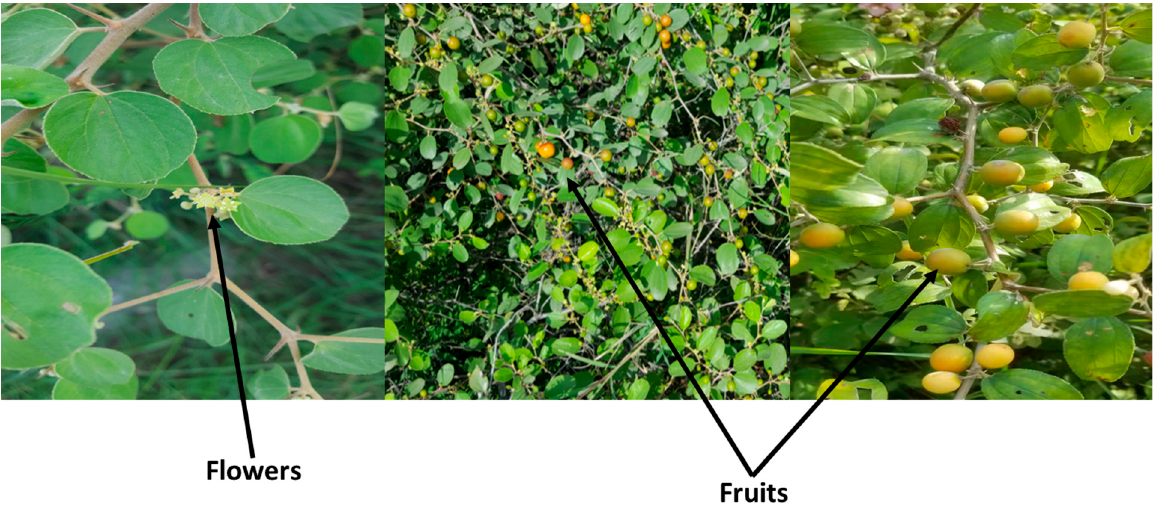
Figure 3. Z. nummularia plant showing leaves, flowers, and fruits. According to Pakistani flora, Z. rugosa is a small tree or straggler shrub with stipular spines that are single or in pairs, a broad base, and fulvous tomentose juvenile branches. The petiole is 0.8–1.5 cm long, and the leaves are 5–12.5 cm long and 4–6 cm wide, broadly elliptic, shortly acuminate, denticulate, and oblique at the base. The inflorescence is com- posed of pedunculate cymes with dense pubescence. The peduncle is 5 mm in length, and the pedicel is 4 mm in length.